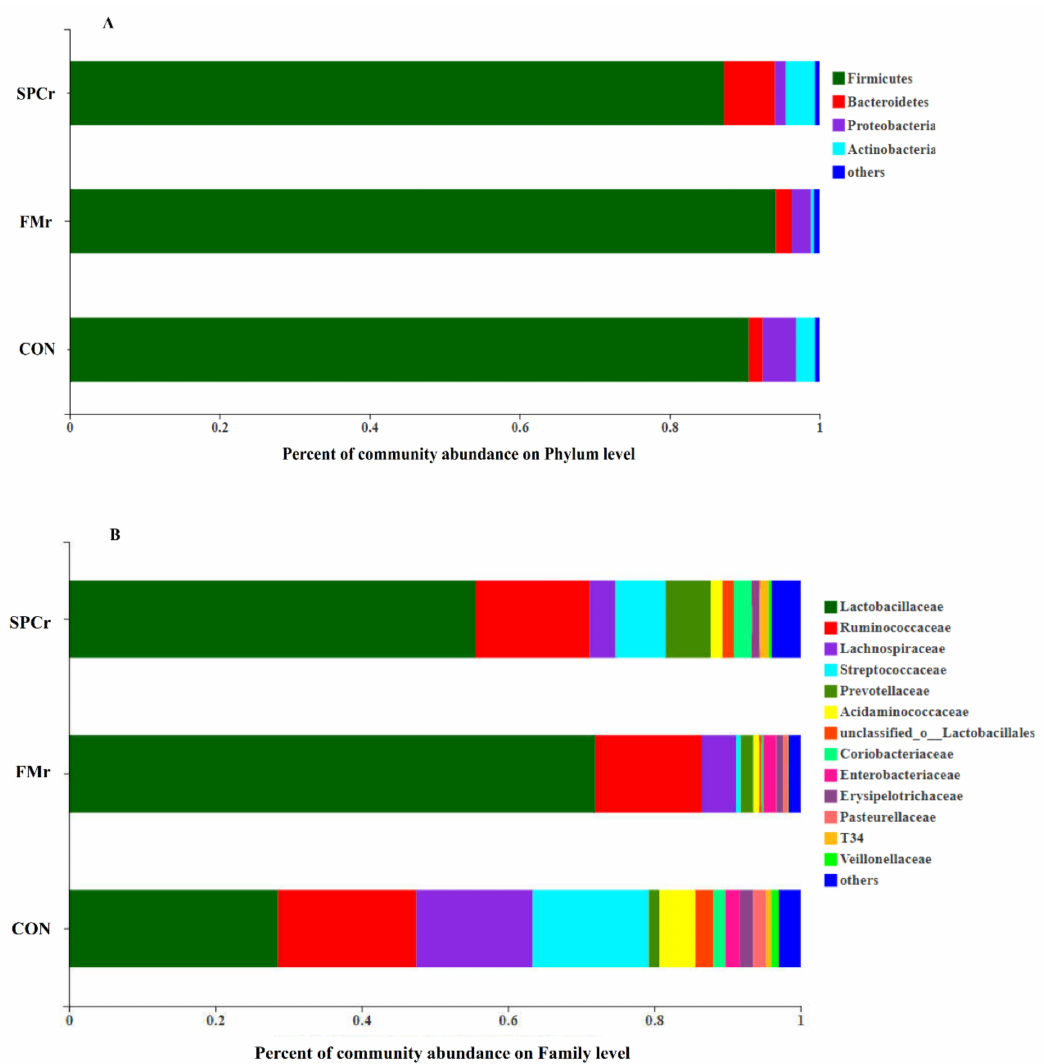
Figure 2. Community structures of cecum bacteria in CON, FMr, SPCr groups on phylum level ( A ) and family level ( B ). The bar plot was used to represent the difference of dominant species at the family levels by Kruskal–Wallis H